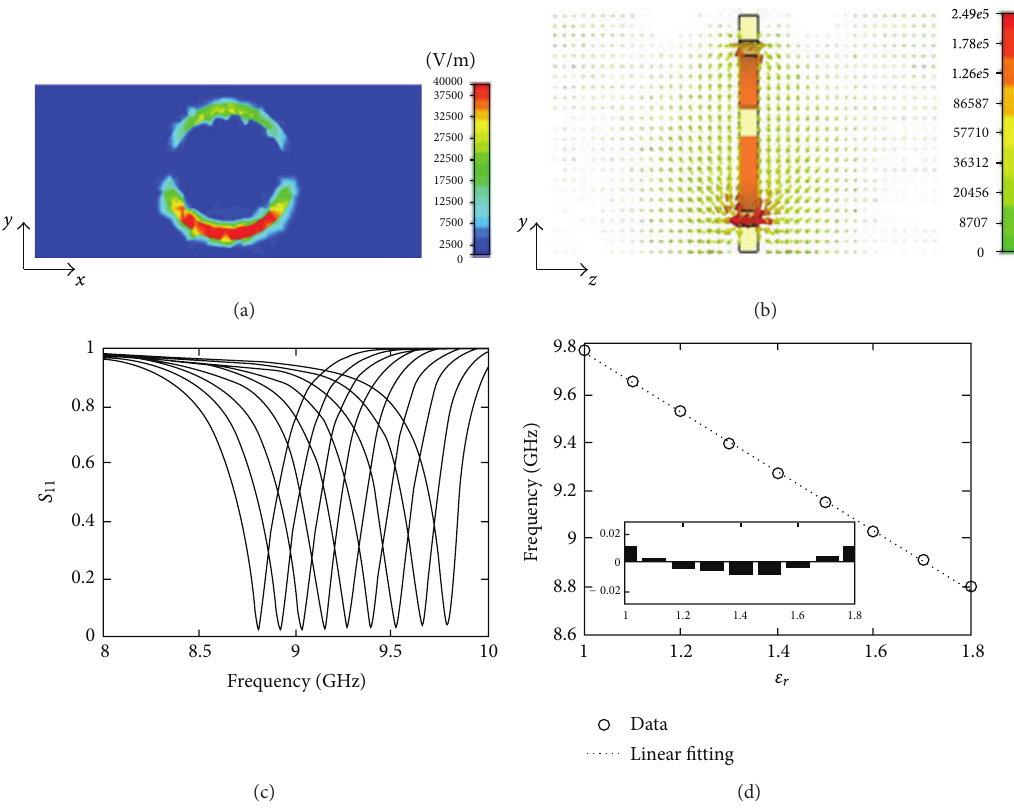
Figure 17: (a) Electric field distribution on the surface of the stereo-CASR at resonant state. (b) Corresponding power flow distribution. (c) Reflection spectra of the sensor for a variation of sample permittivity ( 𝜀 𝑟 ). Curves from right to left correspond to 𝜀 𝑟 = 1 , 𝜀 𝑟 = 1.1 , 𝜀 𝑟 = 1.2 , = 1.8 . (d) The relation between resonant frequency and 𝜀 ... , 𝜀 𝑟 𝑟 . The inset shows the residuals of the linear fitting curve